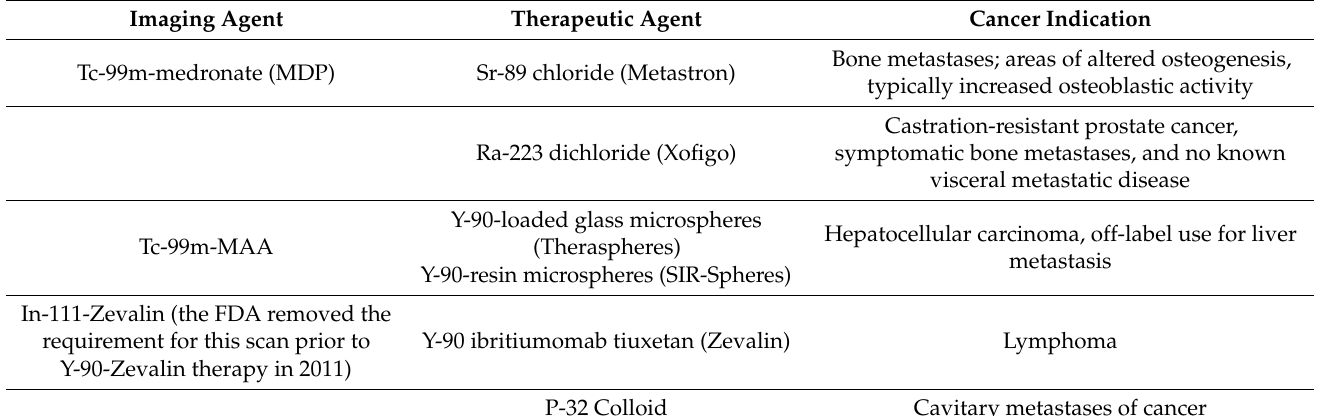
Table 2. Other FDA-approved Radiation